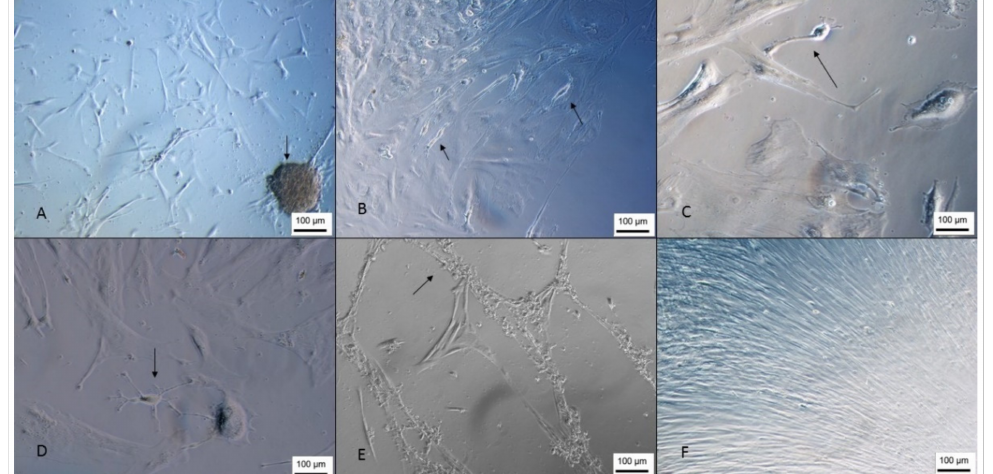
Figure 15. GABAergic differentiation of Neural precursors. ( A ) Cells 4 days after induction (100 × ); ( B ) 8 days after induction (100 × ); ( C ) cells 10 days after induction (200 × ); ( D ) cells 15 days after induction (200 × ); ( E ) 22 days of differentiation (200 × ); ( F ) undifferentiated control—100 × (inverted optical microscopy). Scale bar, 100 µ m.